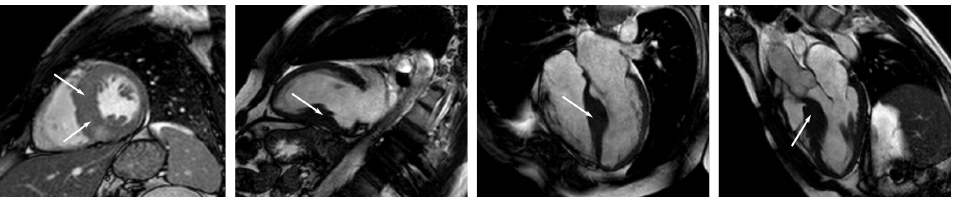
Figure A3. Short-axis cine image and long-axis cine images demonstrate left ventricular hypertrophy in a patient with hypertrophic cardiomyopathy (HCM). Cine images show marked asymmetrical septal hypertrophy (white arrows) corresponding with